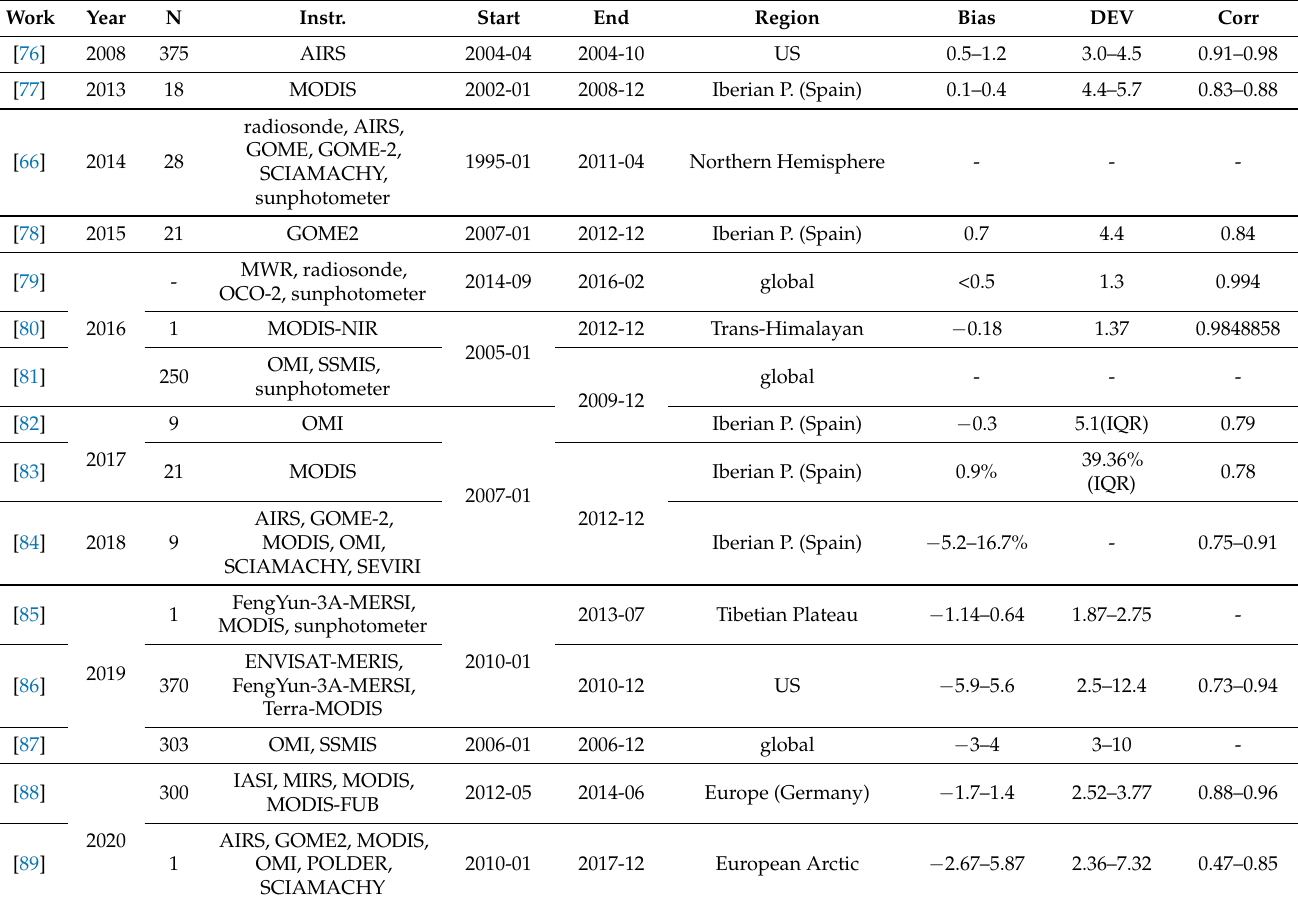
Table 3. Summary of studies on validation of satellite measurements. Column Year is the publication year. N is the number of stations. Instr. is the instruments (besides ground-based GNSS) used in the study. Start and End mark the period considered in the study, in year-month format. Bias is the bias in mm, and DEV is the RMSE or SD also in mm. Corr is the correlation coefficient